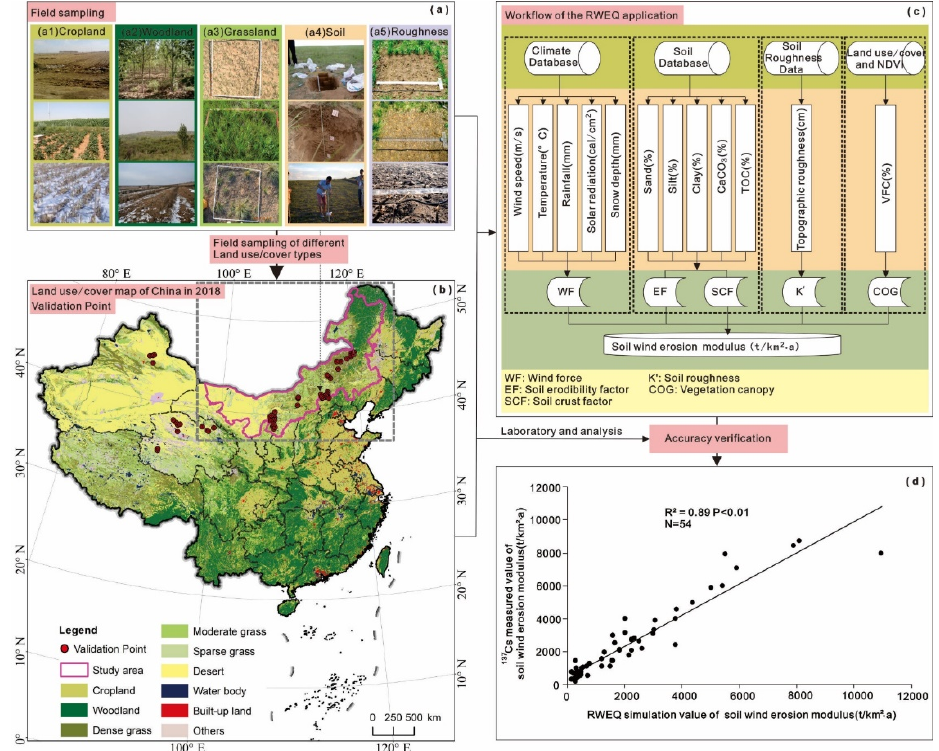
Figure 2. The retrieval and validation of soil wind erosion modulus data: ( a ) photographs of field sampling for accuracy verification, ( b ) spatial distribution of verification points, ( c ) workflow of the revised wind erosion equation (RWEQ) application, and ( d ) the coefficient of accuracy between 137Cs and RWEQ retrieval.